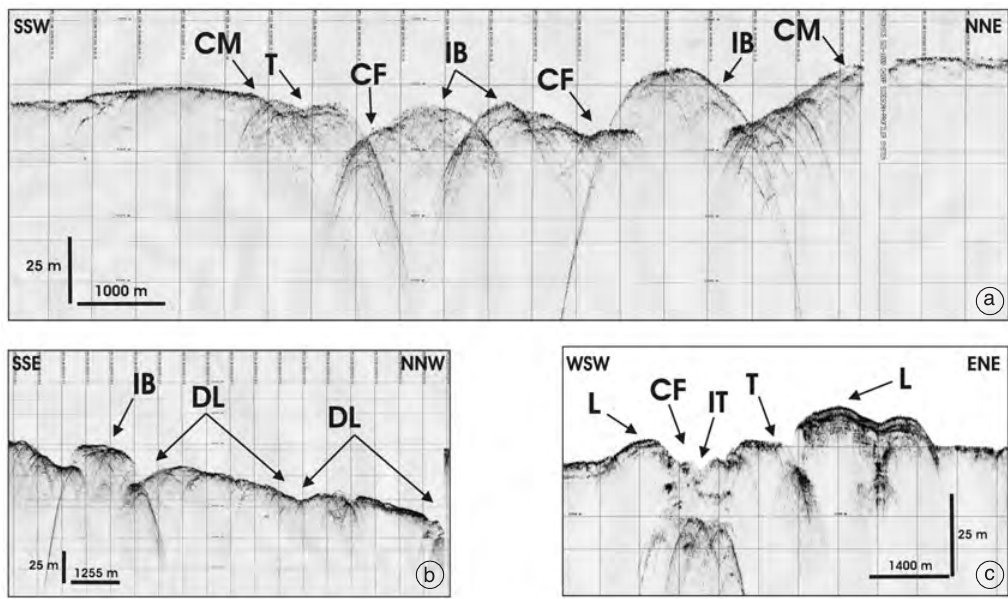
Fig. 4a-c. a) Chirp line crossing the central channel of the Marsili fan (CM – Channel Margin; CF – Channel Floor; IB – Intra-channel Bar; T– Terrace). b) Chirp line crossing two Depositional Lobes (DL) of the Marsili fan that are flanked by a channel with an Intrachannel longitudinal Bar (IB). c) Chirp line crossing the northern- most channel of the Marsili fan (L – Levee; CF – Channel Floor; IT – Inner Thalweg; T –